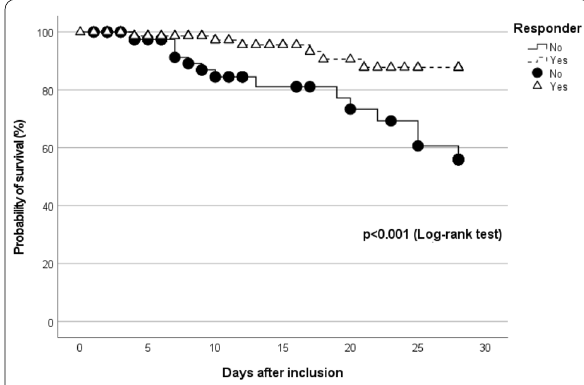
Fig. 3 Probability of survival in critically ill patients with or without a positive response to corporeal rehabilitation